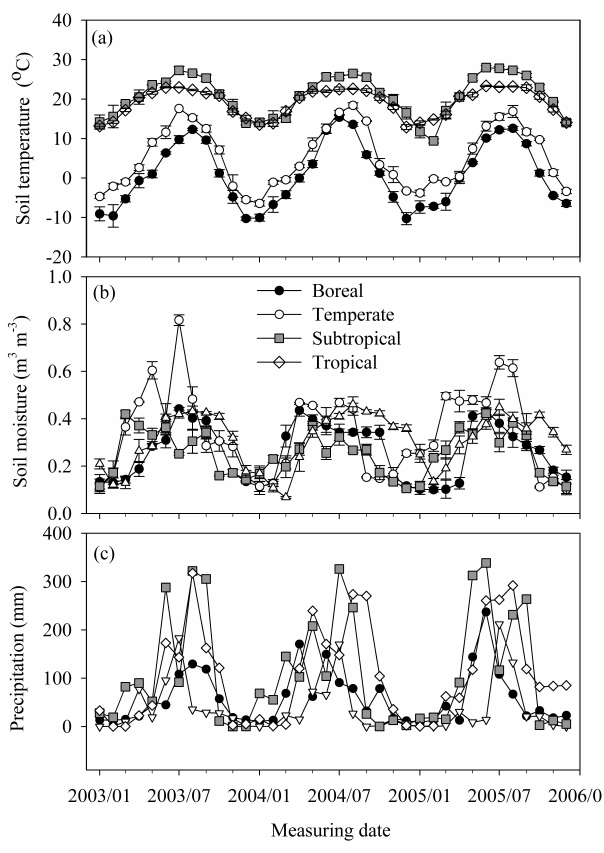
Fig. 2. The seasonal variation of soil temperature and moisture ( ± 1SE) at a depth of 10cm and average precipitation in the four forests from 2003 to